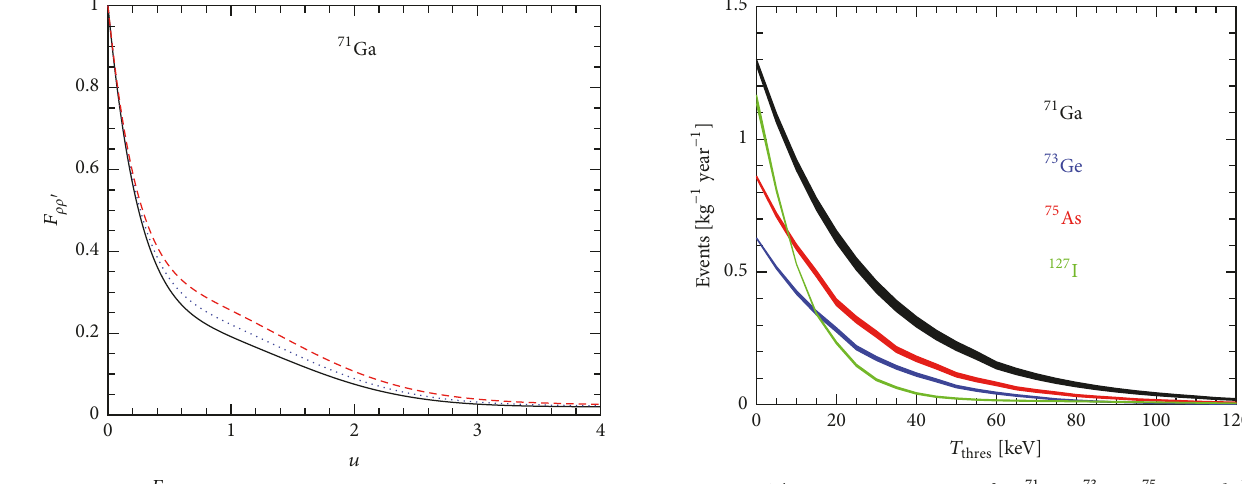
Figure 8: The WIMP event rates for 71 Ga, 73 Ge, 75 As, and 127 I detectors in units of kg −1 year −1 as a function of the detector threshold 𝑇 푁 . The nuclear threshold 𝑇 푁 energy through the limit of the integration in (9). The thickness of the curve represents the annual modulation which decreases with increasing nuclear